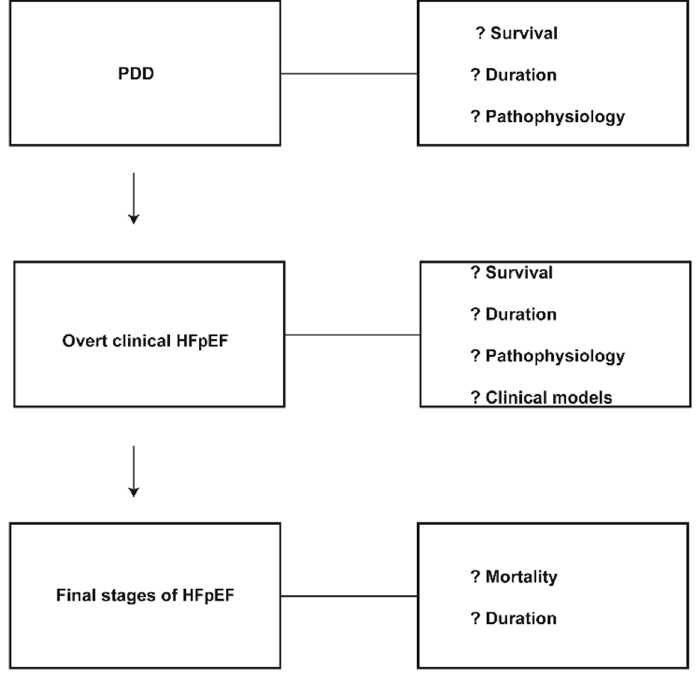
Figure 2. Phases of clinical progression of HFpEF.